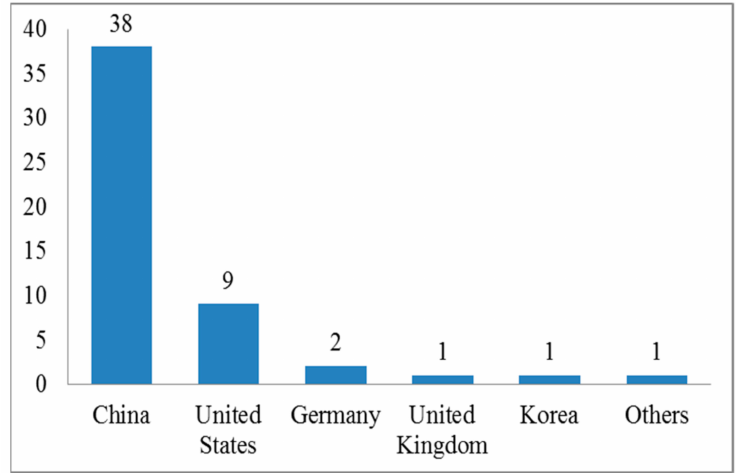
Figure 3. Country-wise location of